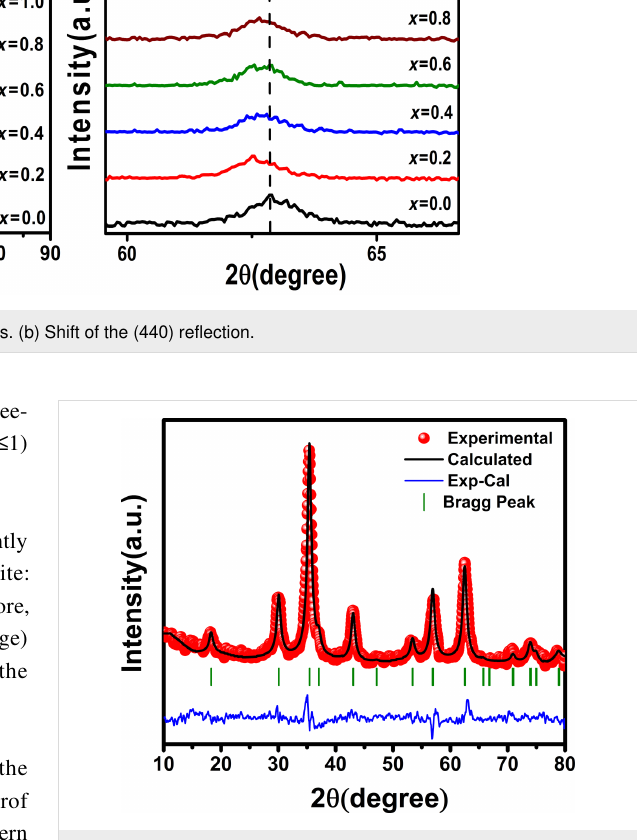
Figure 2: Rietveld-refined XRD pattern of the x = 0.2